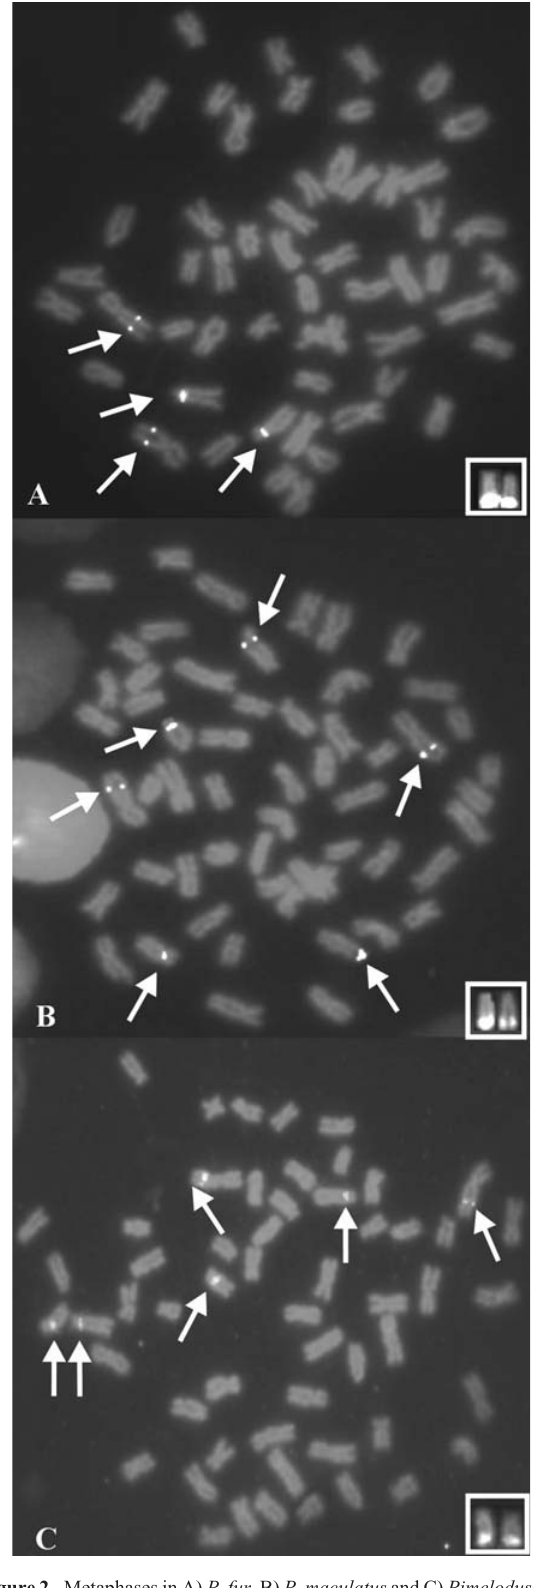
Figure 2 - Metaphases in A) P. fur , B) P. maculatus and C) Pimelodus sp., submitted to FISH with a 5S rDNA probe. The arrows indicate the fluores- cent signals. In detail, the nucleolar organizing chromosomes identified through FISH with an 18S rDNA